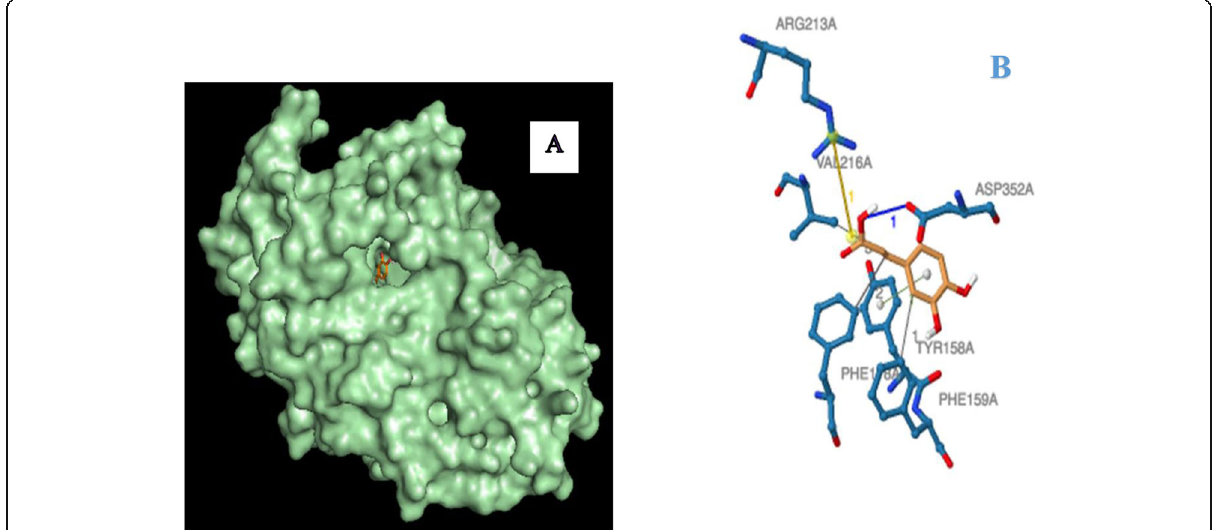
Fig. 1 Binding pose and binding site of caffeic acid with α -glucosidase (panel A), molecular interaction of caffeic acid with amino acid residues within the binding pocket of the protein structure (panel B)